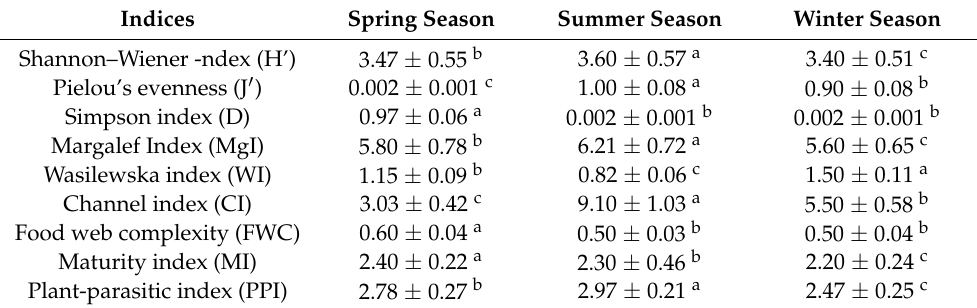
Table 4. Community and diversity indices of soil nematodes of the rice fields during the spring, summer, and winter seasons of the year. Indices Spring Season Summer Season Winter